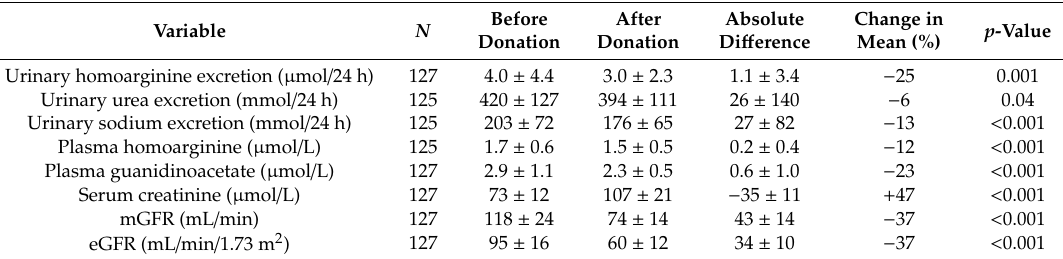
Figure 2. Enzymatic functions of AGAT, showing that guanidinoacetate is further metabolized to creatine and eventually creatinine, while homoarginine is not further metabolized. Table 1. E ff ect of unilateral nephrectomy on biochemical parameters in 127 healthy kidney donors. Study design and methods are described previously